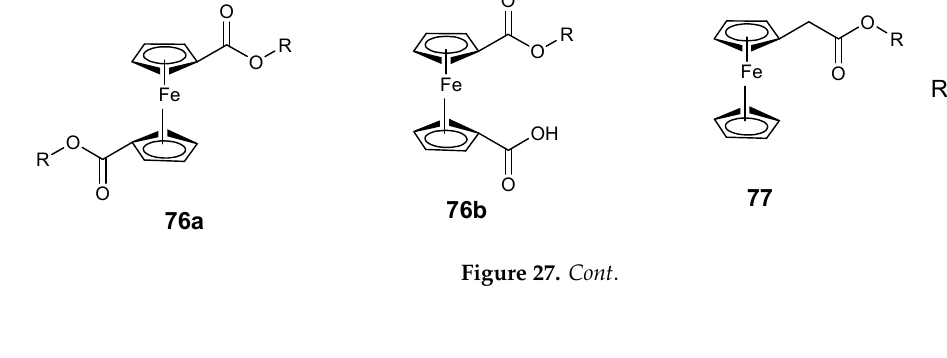
Figure 27. Chemical structures of ferrocene–carboxylate derivatives ( 76 – 80 ). Vera et al. reported ferrocene–carboxylate compounds with phenyl and halogen (F, I, Cl, and Br). Compound 78a exhibited good antiproliferative activity against MCF-7 cancer cells with an IC 50 value of 9.2 µM and compound 78b exhibited high antiproliferative activity against MCF-10A cancer cells with an IC 50 value of 7 µM [74,75] (Figure 27). Compound 79 anticancer activity was significant against both MCF-7 and MCF-10A cancer cells with IC 50 values 1.4 and 1.6 µM respectively [73,74]. Compound 78a and 80 showed moderate antiproliferative activity against HT-29 cancer cells with IC 50 values of 24.4 and 24.0 µM, respectively [73,74] (Figure 28). The in vitro anti-proliferative studies indicated that the presence of 4-fluorophenyl substituent in the compounds resulted in compounds with no cytotoxic effect against the cancer cell lines. However, the presence of a phenyl group enhanced the proliferative effects of the compound against MCF-7 but nullified the proliferative effect of the compound against the MCF-10A cell line. 4.8. Ferrocene Incorporated Selenourea Derivatives Hussain et al. reported ferrocene incorporated with selenourea derivatives ( 81a – q ) (Figure 28) and tested them for their anticancer activity against liver cancer (Hepa 1c1c7), breast cancer (MCF-7), and neuroblastoma (MYCN2 and SK-N-SH), in vitro. Only four compounds ( 81c , 81h , 81j , and 81m ) exhibited moderate anticancer activity against the aforementioned cells, compound 81c displayed moderate cytotoxicity activity against MYCN-2 and MCF-7 with inhibition values of 26.5 and 27 µM, compound 81h exhibited better anticancer activity against MYCN-2 with an inhibition value of 12.2 µM, compound 81j was slightly cytotoxic with an IC 50 value of 18.9 µM against MYCN-2 and compound 81m showed low anticancer activity against MYCN-2 with inhibition value of 38.9 µM [75]. The ortho substitution on the phenyl ring attached with the carbonyl carbon influenced the cytotoxic effect of the compounds significantly. The aromatase inhibition and quinone reductase induction activities of the compounds further revealed their capability to inhibit the cancer initiation and propagation.